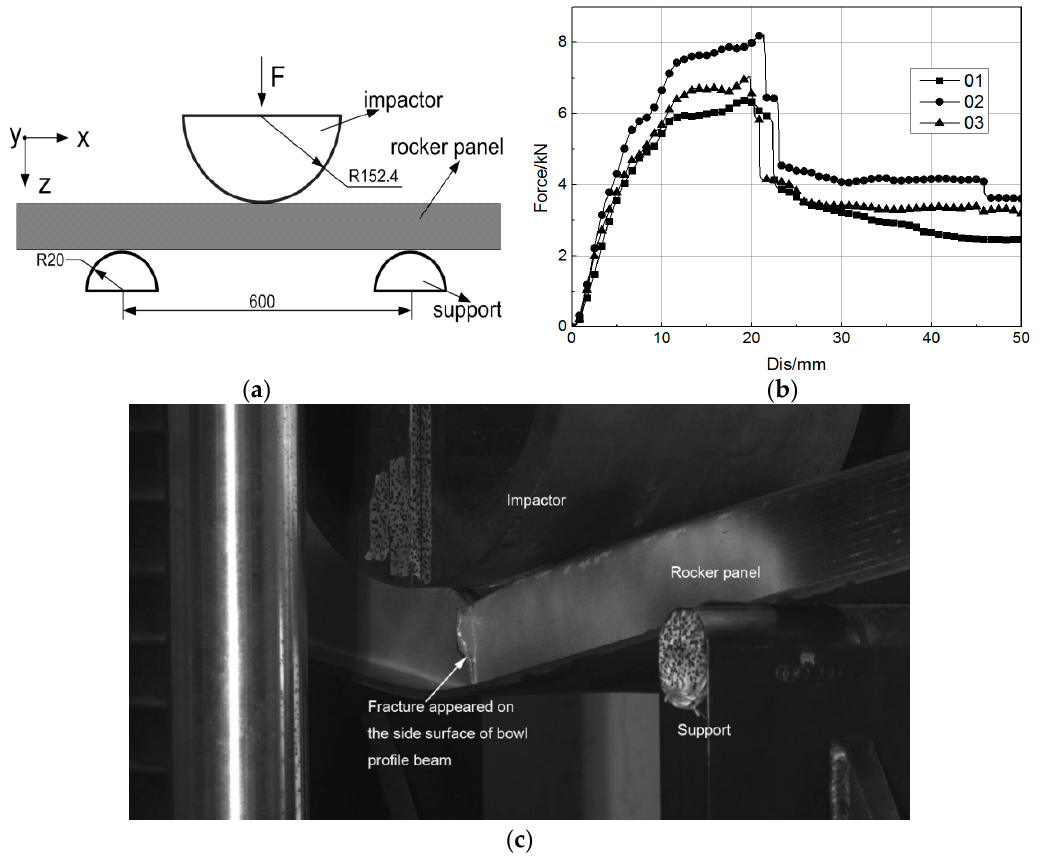
Figure 3. Three-point bending test. ( a ) Three-point test diagram. ( b ) Force–displacement curve. ( c ) Onset of fracture.